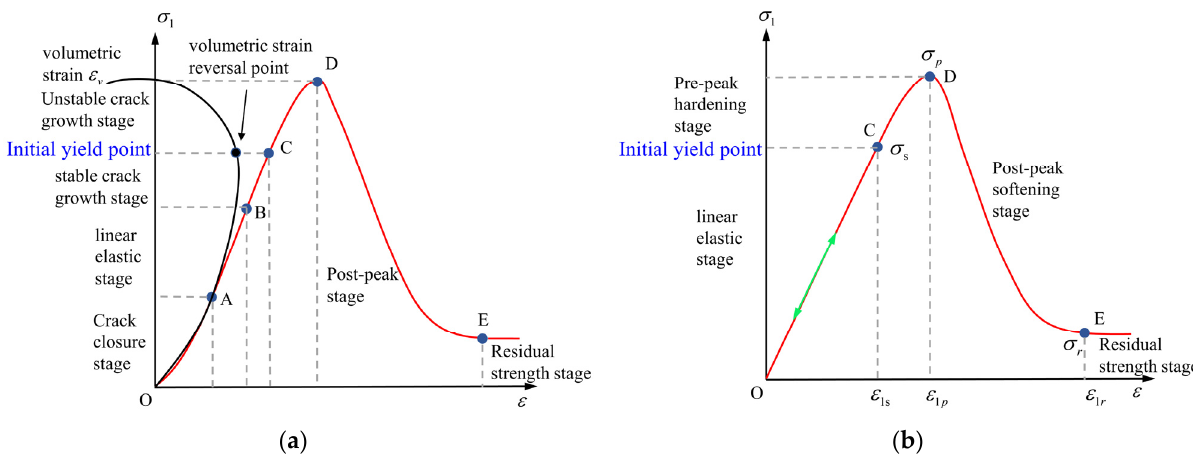
Figure 1. Complete stress ‒ strain curve. ( a ) typical [31], ( b ) simplified.